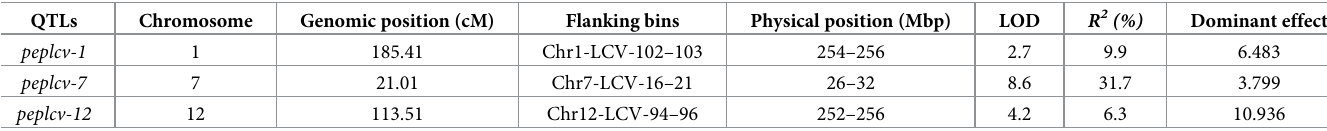
Table 3. QTL analysis for resistance to PepYLCV Indonesia strain in the LP97-F 2 population using composite interval mapping.